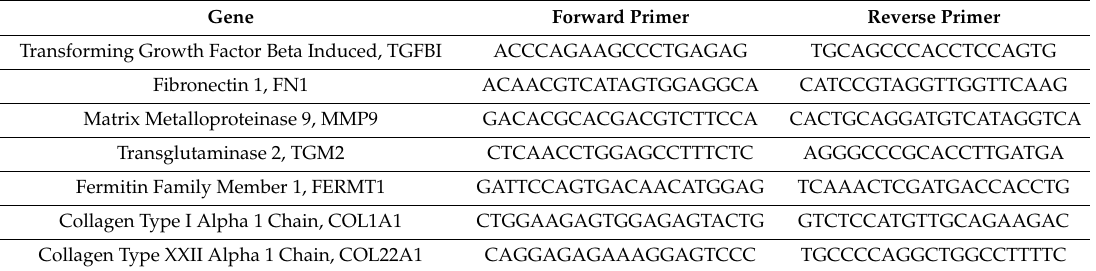
Table 1. Primer sequences used to analyze gene expression of the indicated ECM-related factors by real-time